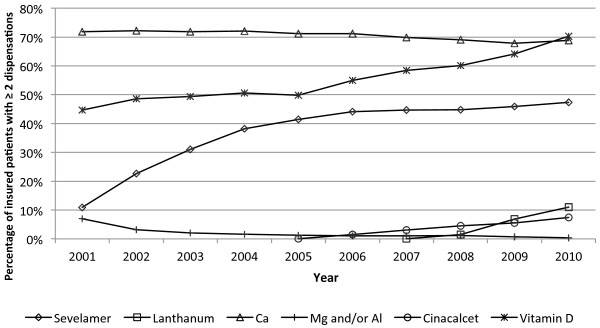
Trends in selected medication use. Note: Vitamin D category includes vitamin D and analogues. Abbreviations: Ca, calcium-containing phosphate binders; Mg, magnesium-containing phosphate binders; Al, aluminum-containing phosphate binders.